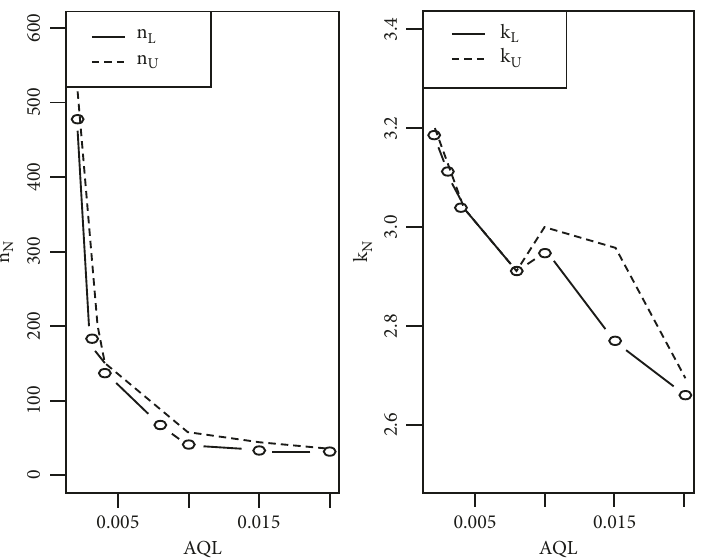
Figure 3: Trend in 𝑛 𝑁 𝜖{𝑛 𝐿 , 𝑛 𝑈 } and 𝑘 𝑁𝑎 𝜖{𝑘 𝐿𝑎 , 𝑘 𝑈𝑎 } when 𝛼 = 0.05 , 𝛽 =0.05, 𝑟